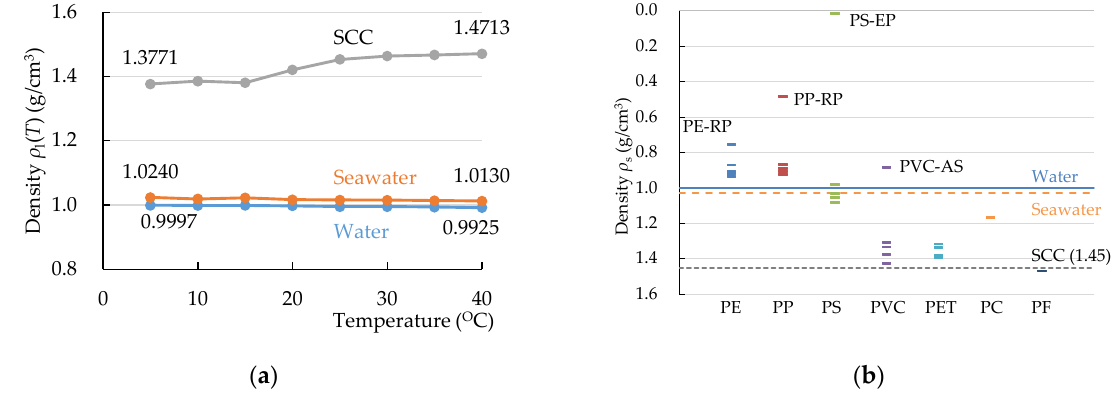
Figure 9. ( a ) Relationship between temperature and density of liquid samples ρ l ( T ) (n = 6, mean). ( b ) Densities of solid samples ρ s (n = 6, mean).